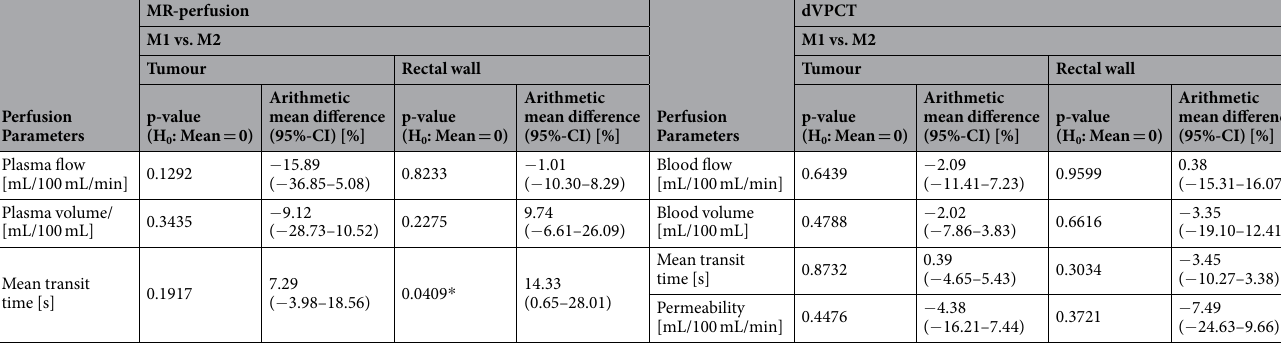
Table 4. Assessment of Intra-reader variability of MR-Perfusion and dVPCT – Bland-Altman analysis. Arithmetic mean differences are presented as % from the mean of M1 and M2. CI = confidence interval. * indicates statistical significance.